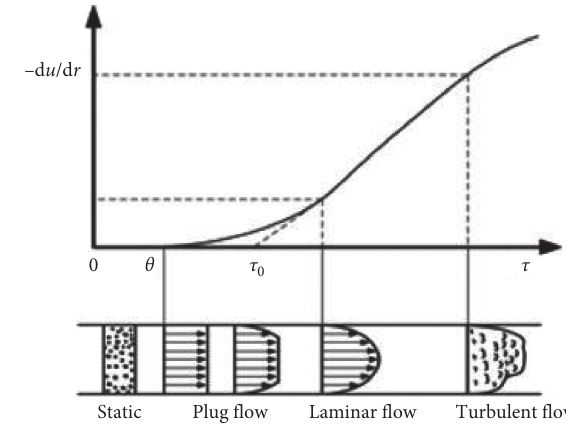
Figure 16: Flow pattern of grease flat extrusion.